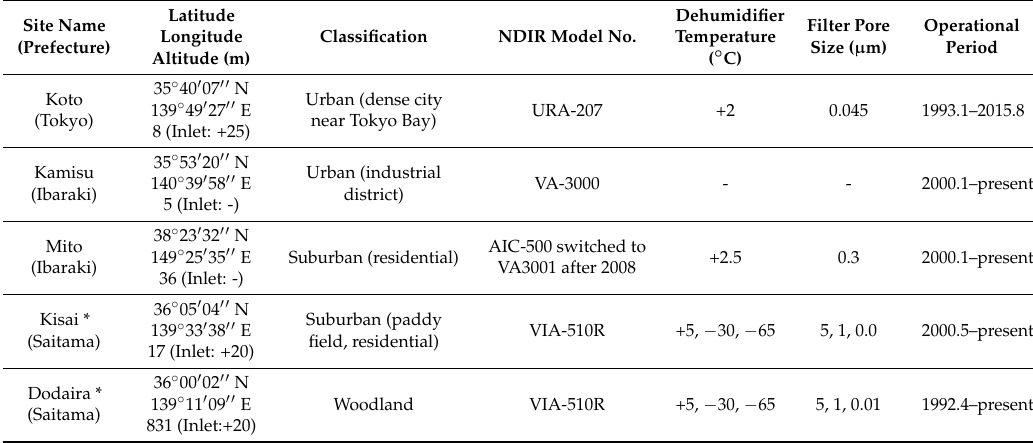
Figure 2. Aerial photographs of ( a ) Koto (Tokyo), ( b ) Kamisu (Ibaraki), ( c ) Mito (Ibaraki), ( d ) Kisai (Saitama), and ( e ) Dodaira (Saitama). Images are based on Google Earth [17]. Table 1. Site characteristics and instruments. NDIR: non-dispersive infrared absorption; WDCGG: World Data Centre for Greenhouse Gases.